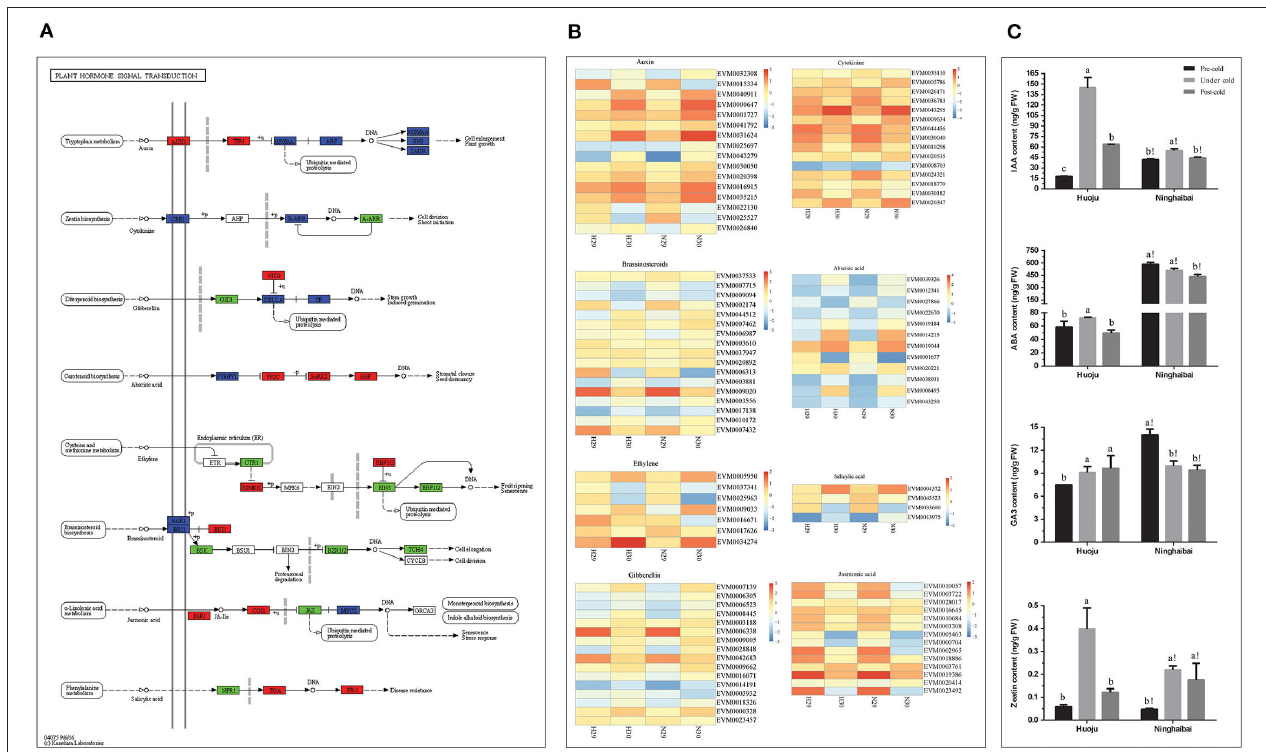
FIGURE 5 | The KEGG pathway annotation diagram of the “plant hormone signal transduction pathway” of DEGs and dynamic changes of endogenous hormones in loquat rachises under cold stress. (A) KEGG analysis exhibiting the enrichment of DEGs in the “plant hormone signal transduction pathway”; (B) heatmap shows the expression of DEGs correlated with different hormones, such as auxin, cytokinin, gibberellin, abscisic acid, ethylene, brassinosteroid, jasmonic acid, and salicylic acid in “Huoju” and “Ninghaibai.” The bar represents the expression level of each gene as indicated by blue (lower expression) and dark yellow (higher expression). (C) Changes in the level of plant hormones, including IAA, ABA, GA3, and zeatin, under cold stress in rachises of loquat. Different letters indicate the significance at p < 0.05, out of which a, b, and c indicate the significant difference of “Huoju,” whereas a!, b!, and c! indicate the significant difference of “Ninghaibai.” Error bars indicate the standard deviation based on three